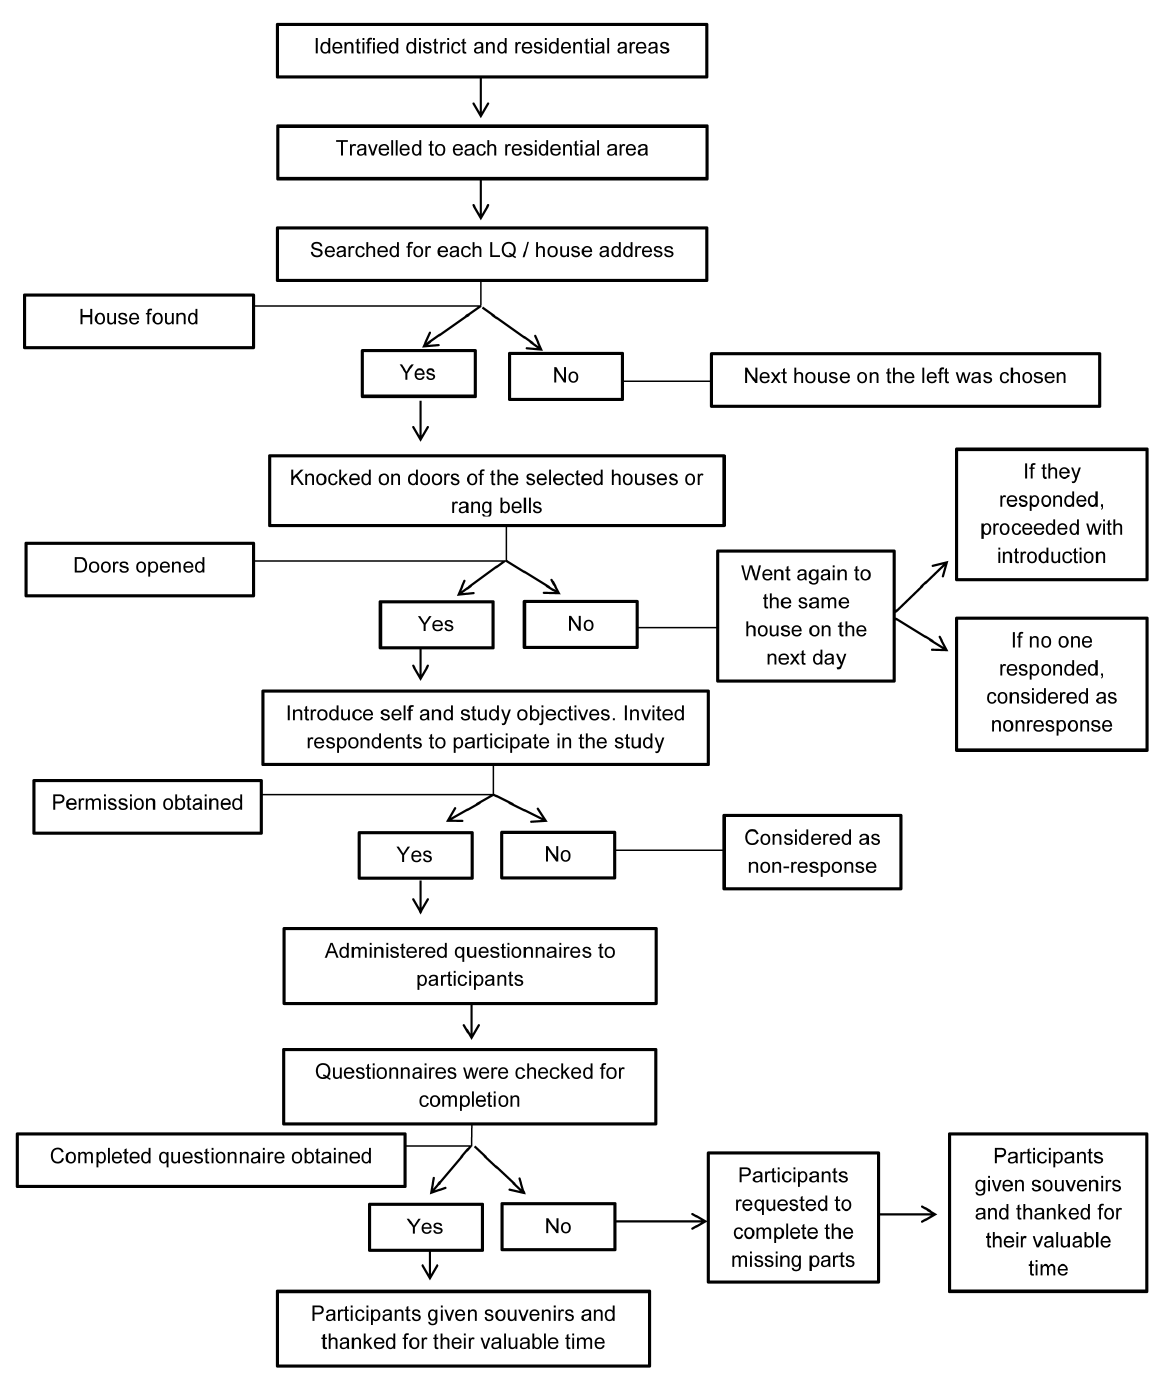
Figure 3. Flow chart of data collection process. The above figure shows the flow chart of the detailed data collection process, starting from the arrival at the selected houses until the end of the data